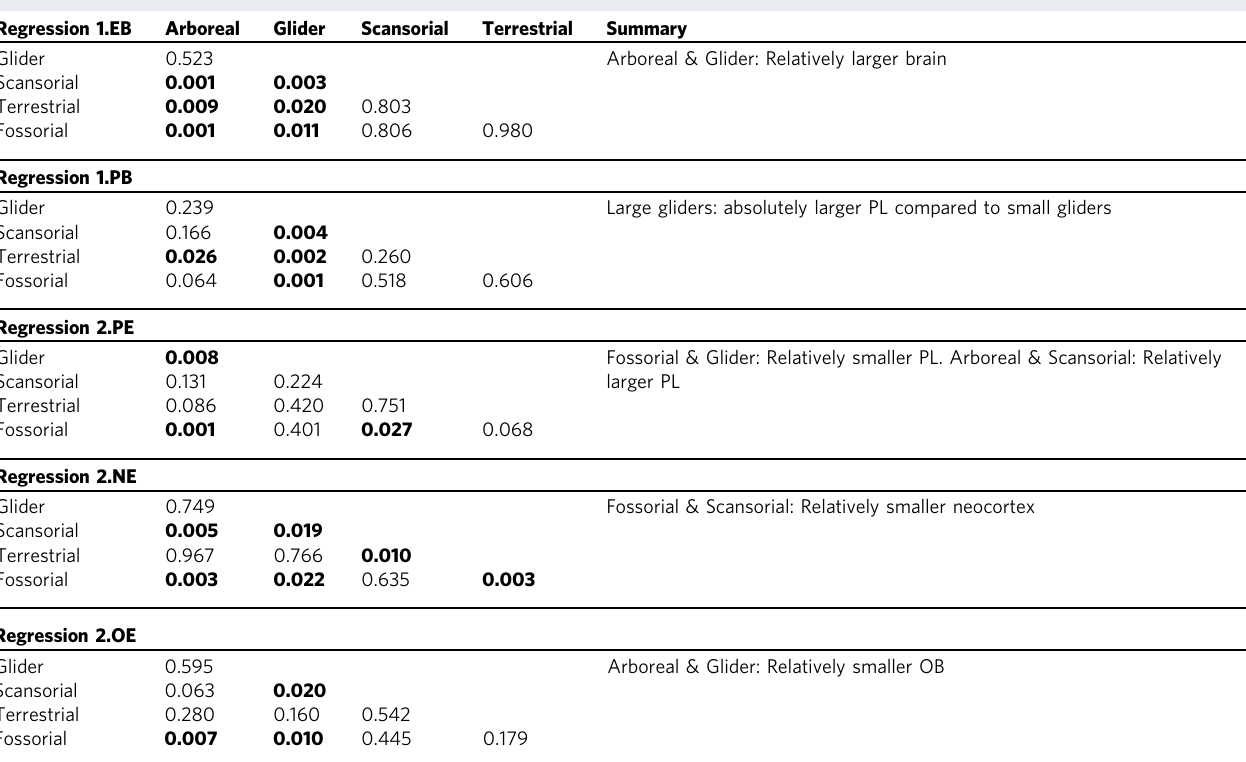
Table 3 . Non-phylogenetically corrected post-hoc pairwise comparisons P-values for the different locomotor modes in